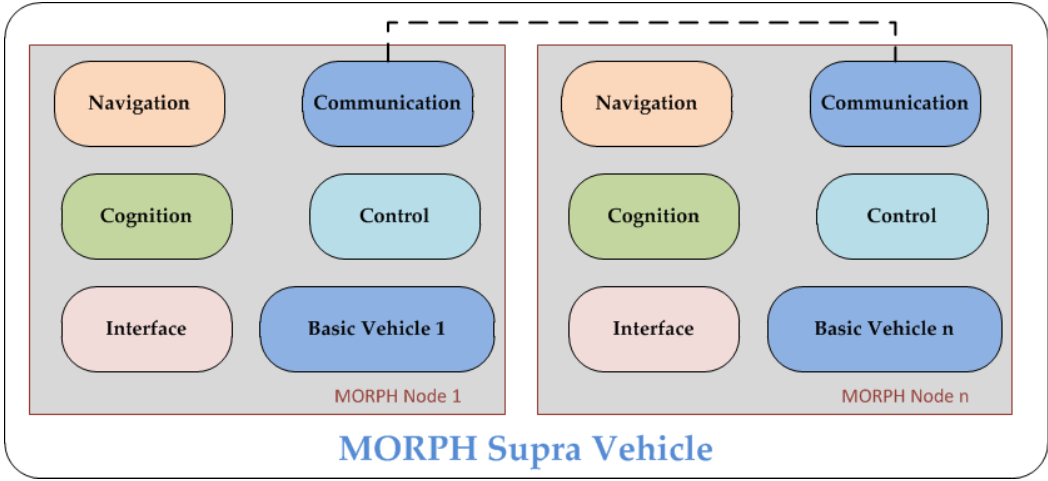
Figure 16. Architecture of a MORPH node and MORPH Supra Vehicle, as described in [60].